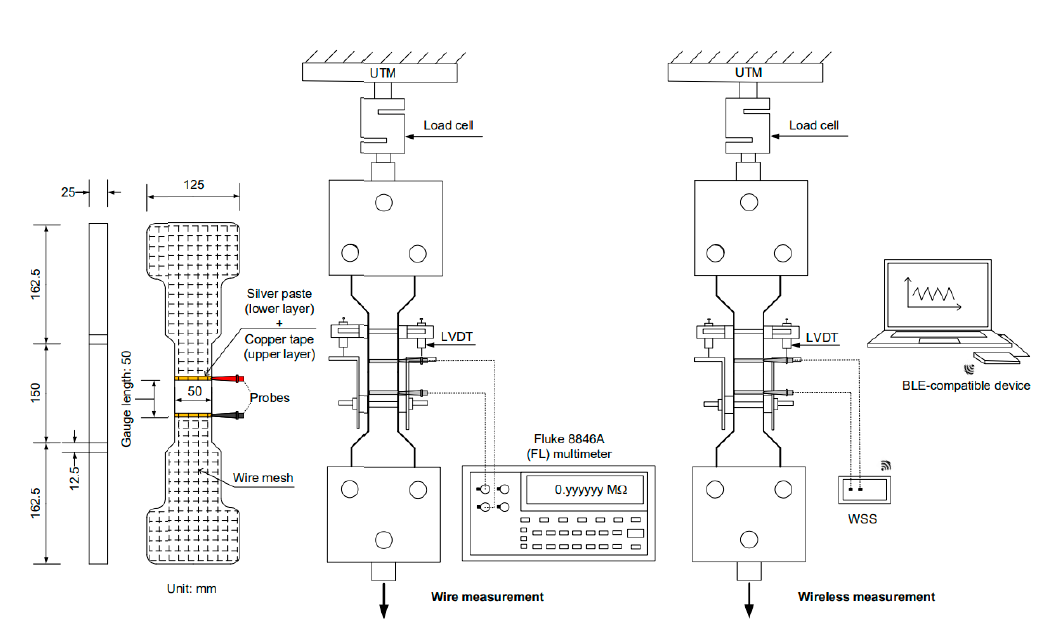
Figure 10. Electrical resistance measurement using wire and WSS measurements under tension.